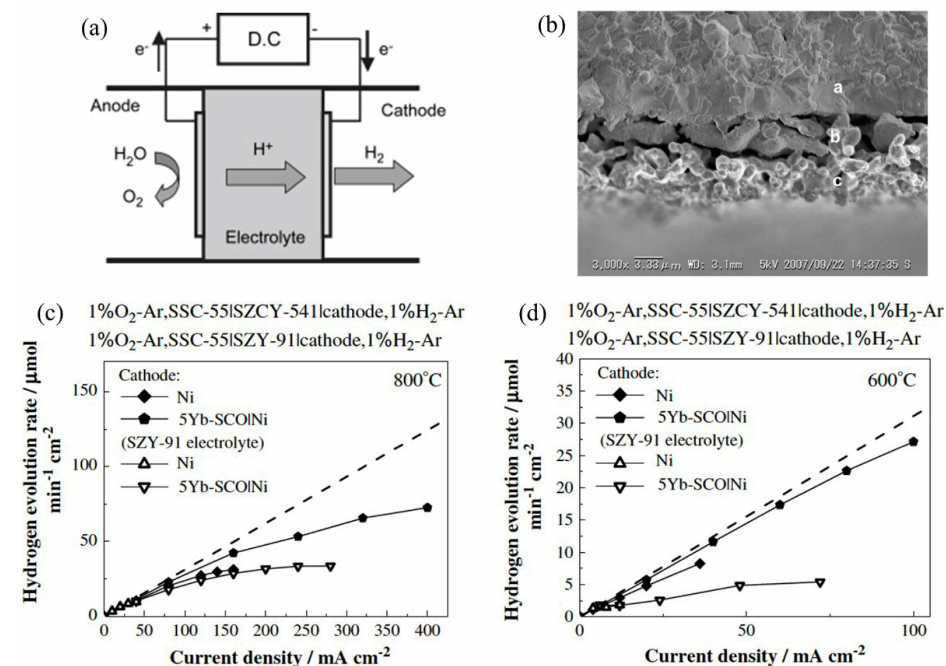
Figure 11. ( a ) Operating principle of steam electrolysis cells based on proton-conducting electrolytes ( b ) SEM images of the cross section of SCYb interlayer SZCY-541 electrolyte (top), SCYb interlayer (middle) and nickel electrode (bottom) ( c , d ) hydrogen evolution rate of the steam electrolysis cell with SZCY-541 electrolyte, SSC-55 anode, nickel cathode and SCYb interlayer at 800 ◦ C ( c ) and 600 ◦ C ( d ). Reprinted with permission from Ref. [112]. Copyright 2009